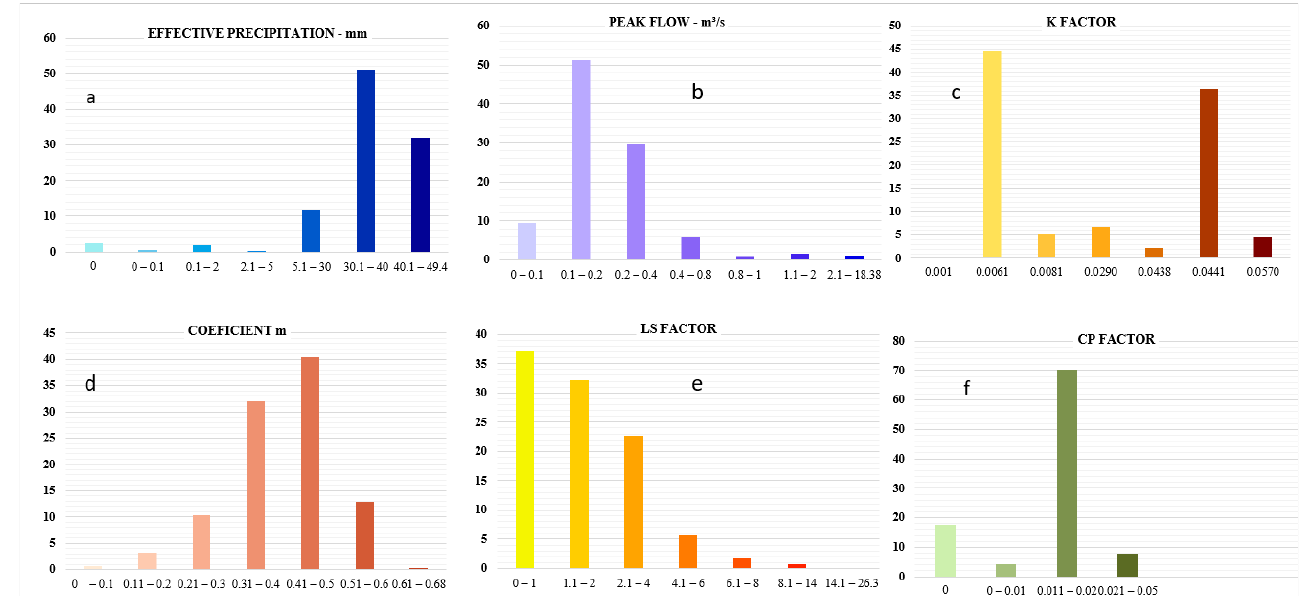
Figure 5. Classes of effective precipitation ( a ); peak flow ( b ); soil erodibility ( c ); m coefficient ( d ); LS factor ( e ); CP factor ( f ) and respective percentages of coverage areas.